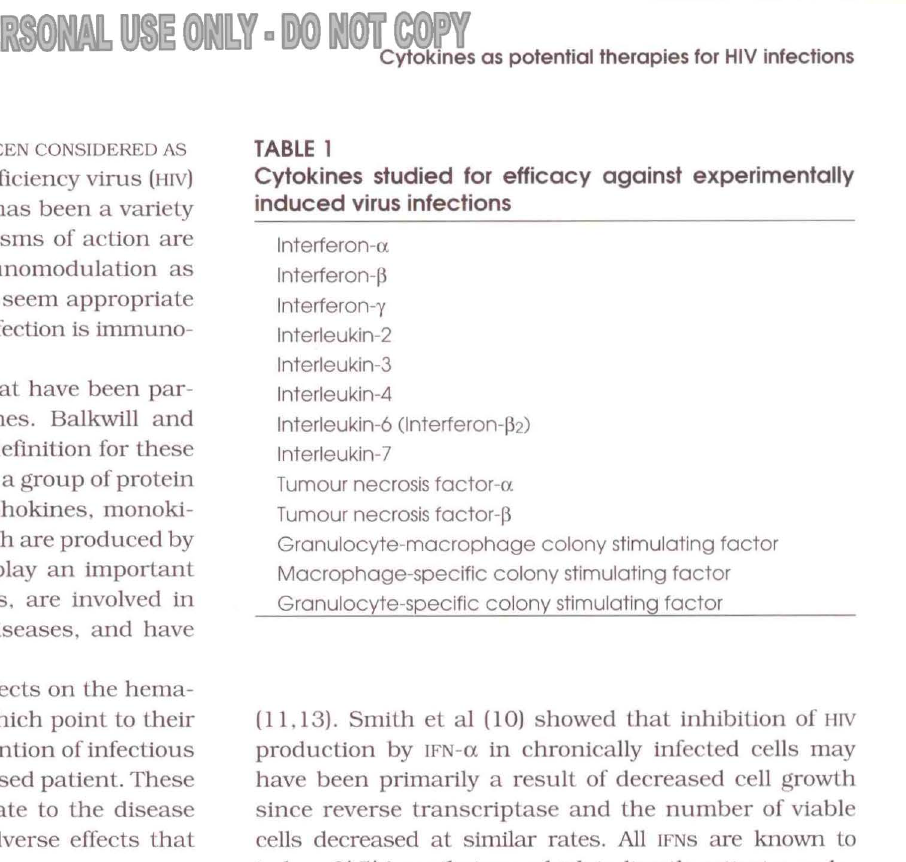
Cytokines studied for efficacy against experimentally induced virus